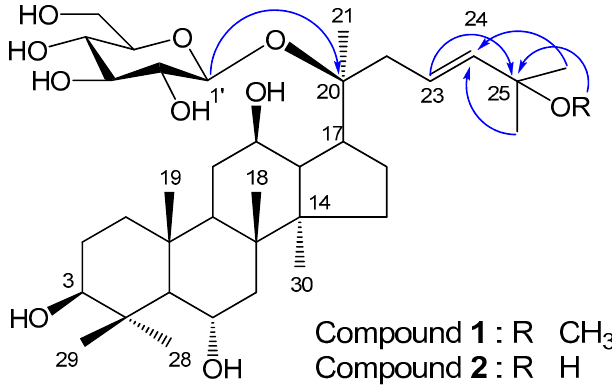
Figure 1. Chemical structures of compounds 1 and 2 , and key gHMBC (arrow) correlations of 1 . Table 1. 1 H- (400 MHz) and 13 C-NMR (100 MHz) spectra of compounds 1 and 2 (in pyridine- d 5 ). Compound 1 Compound